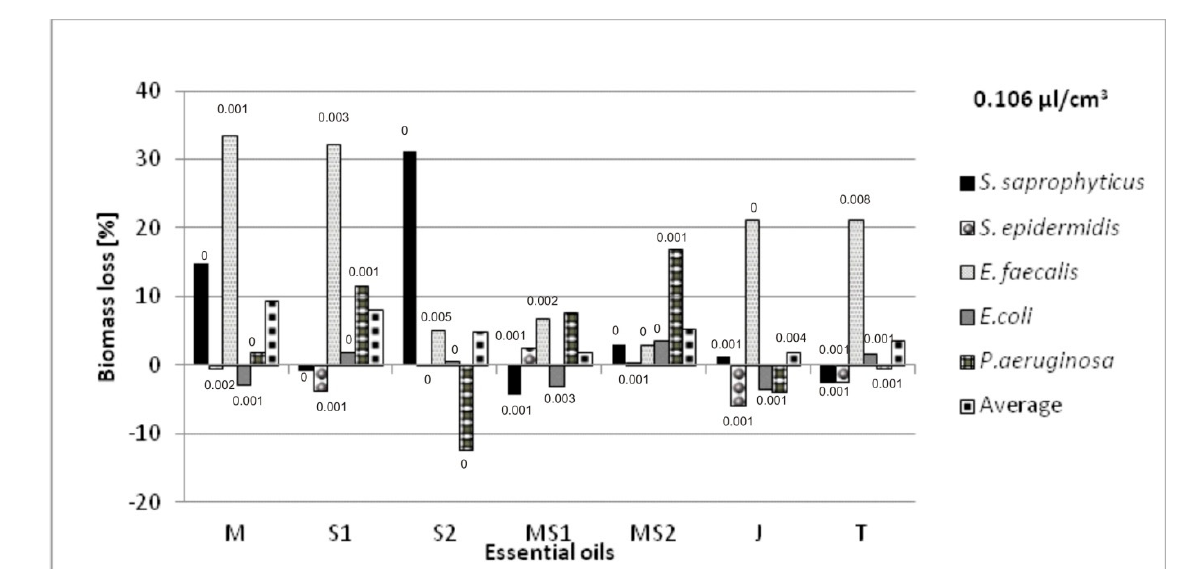
Figure 3. Antimicrobial activity of essential oils in a vapor phase at the oil concentration of 0.054 µL/cm 3 in the atmos- phere, where: M— Matricaria chamomilla L.; S1— Salvia officinalis L.; S2— Salvia lavandulaefolia Vahl.; MS1— Matricaria chamomilla L. with Salvia officinalis L.; MS2— Matricaria chamomilla L. with Salvia lavandulaefolia Vahl.; J— Juniperus com- munis L.; T— Thymus vulgaris L. Results are presented as an average value of three repetitions with ±SD < 0.01 (values of SD placed above the bars); all the results were statistically different ( p < 0.05).